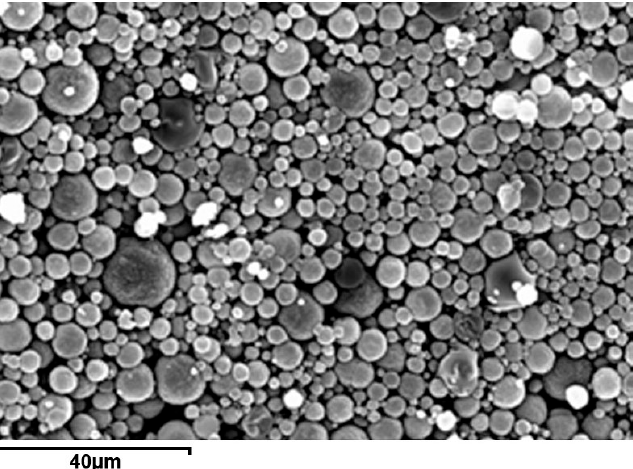
Figure 3. Scanning electron images of chitosan-ibuprofen microparticles obtained by spray drying. Reprinted with permission from [31]. Copyright© 2012 Elsevier.